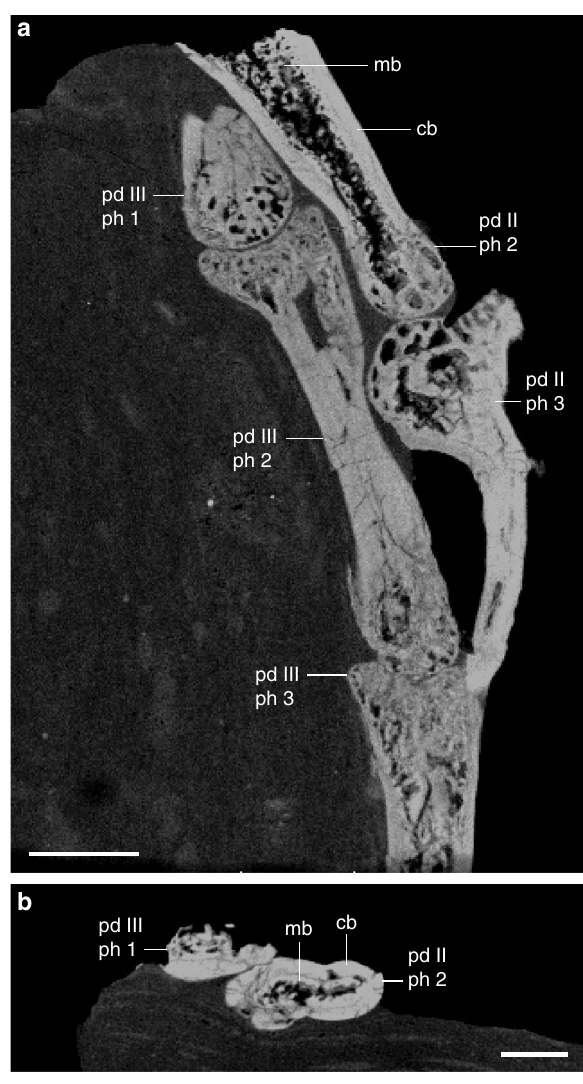
Fig. 4 CT-scans of the distal pedal phalanges showing the penultimate phalanx of pedal digit II with small amounts of medullary bone lining the internal cavity. a Medial slice along the x -axis showing pedal digits II and III; b same section, y -axis. Scale bar equals 1000 μ m. Anatomical